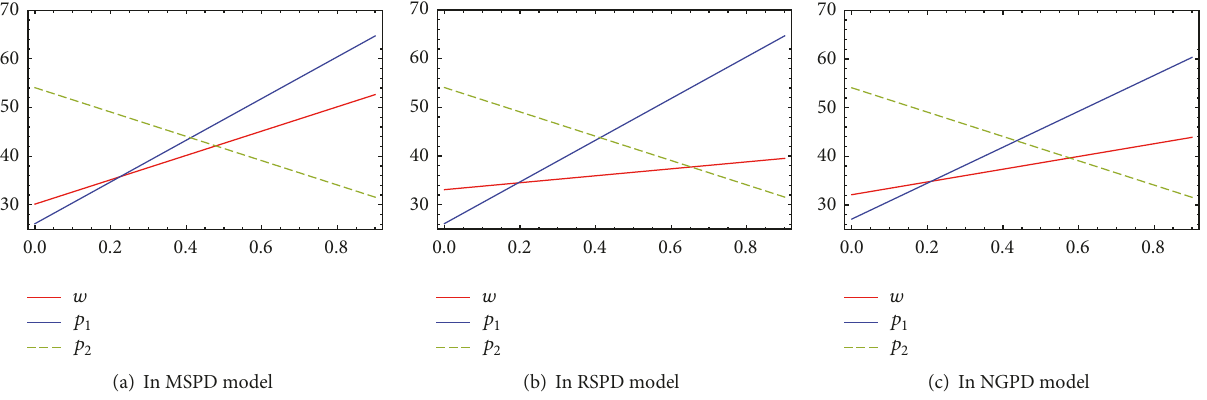
Figure 5: The change of optimal decisions profits with the parameters 𝜃 .